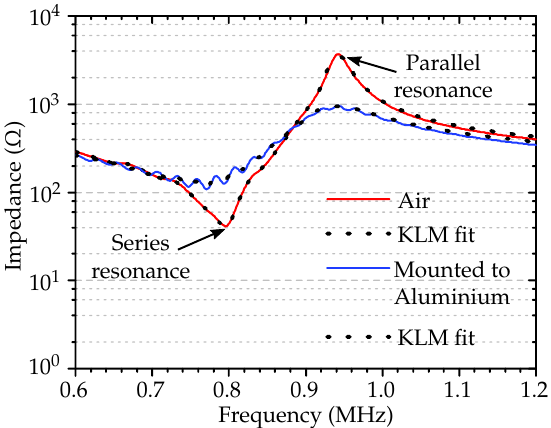
Figure 3. Measured electrical impedance (lines) and the KLM model fit (dots) of the transducer in air and after being mounted to the aluminium.